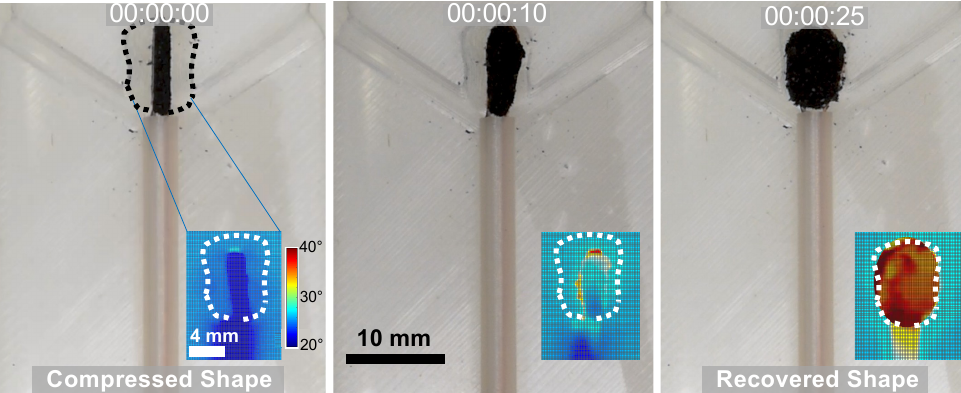
Figure 6. Photos and thermography images (insets) of the shape recovery process of a CNT-infiltrated polyurethane SMP foam developed in our lab. This experiment was performed in an in-vitro bifurcation aneurysm model that mimics a patient-specific aneurysm